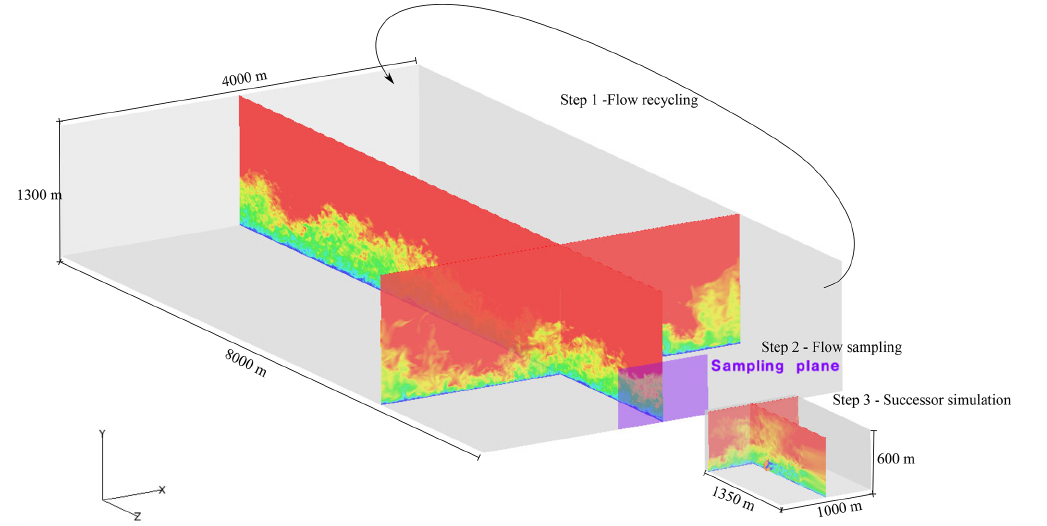
Figure 2. Concept of precursor to successor simulations along with domain sizes of conducted precursor and successor simulations. Colored contours showing flow velocity W